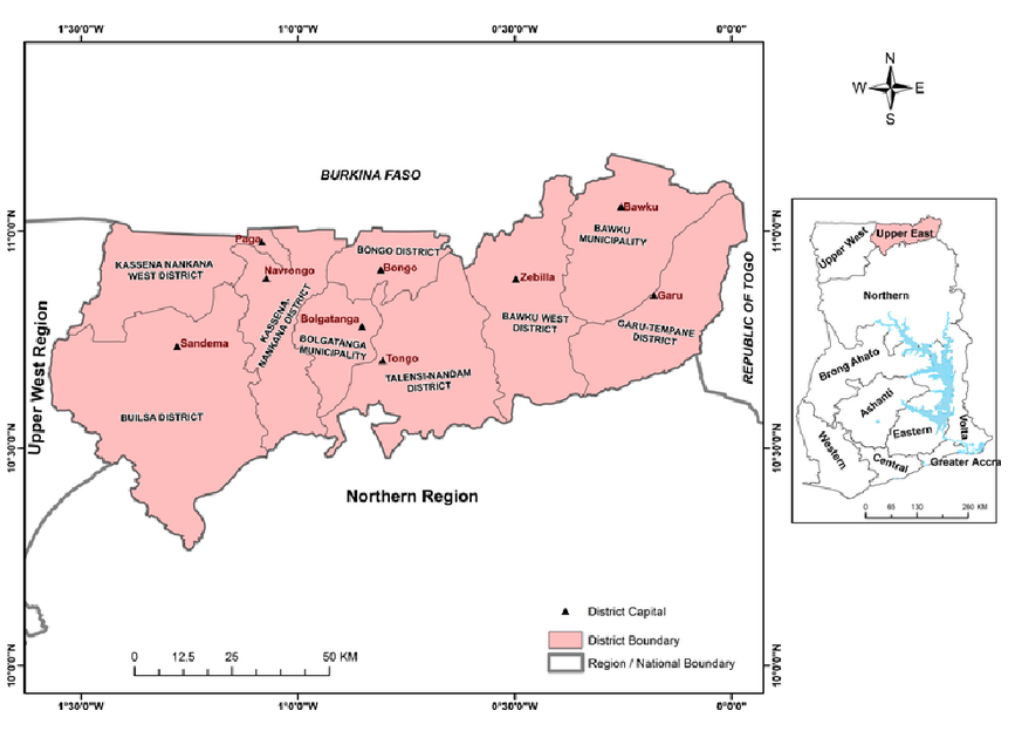
Figure 1. Map of Ghana Showing Upper East Region and its Districts including Bolgatanga Municipality. Source: [22].